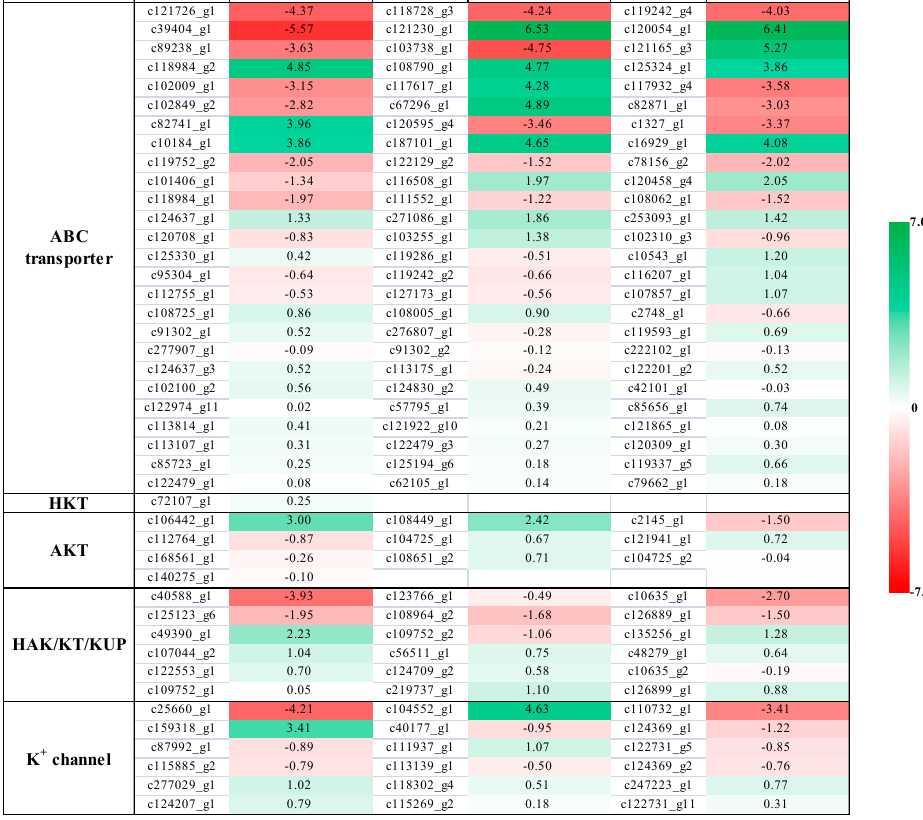
Figure 4. Expression profiles of transporter families. The green means upregulation and the red means downregulation of gene expression at K + deficiency treatment. The value of 0 represents no change in gene expression between K + starvation treatment (TP02) and normal K + treatment (TP01). The value represents fragments per kilobase million (FPKM).